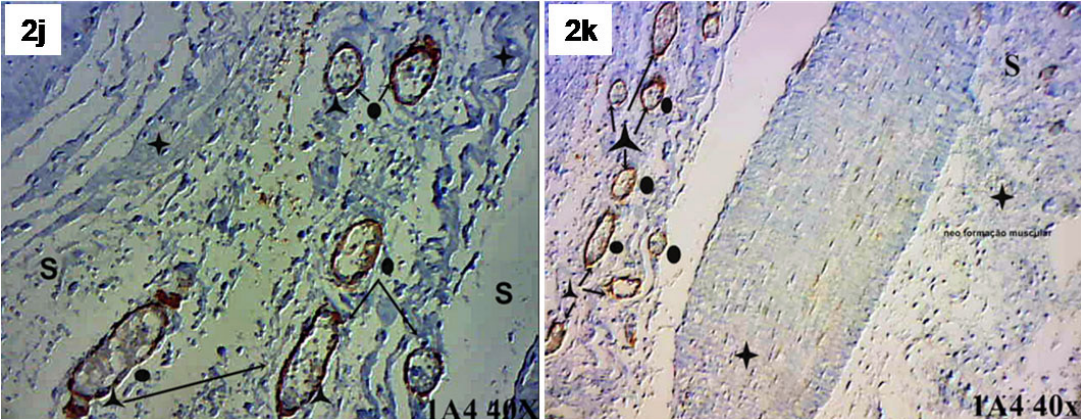
Fig. 2 – J,K) Submucosa (S), blood vessels (o), smooth muscle fiber (λ) and muscle fiber negative for actin 1A4 (+). Actin 1A4,